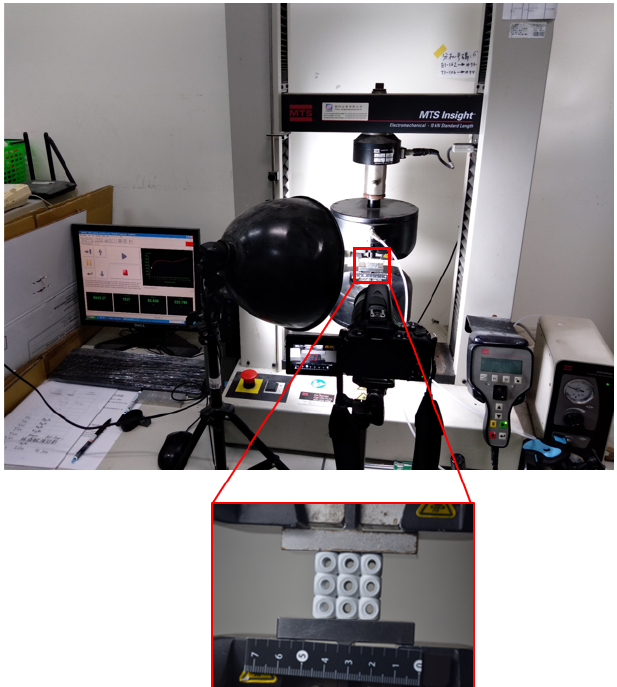
Figure 4. Uniaxial compression testing setup.